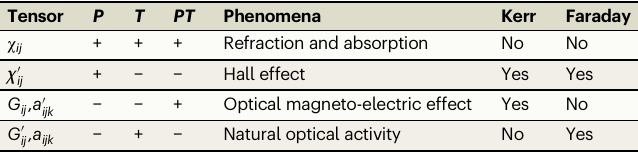
Table 1 | Symmetry properties of electromagnetic linear response